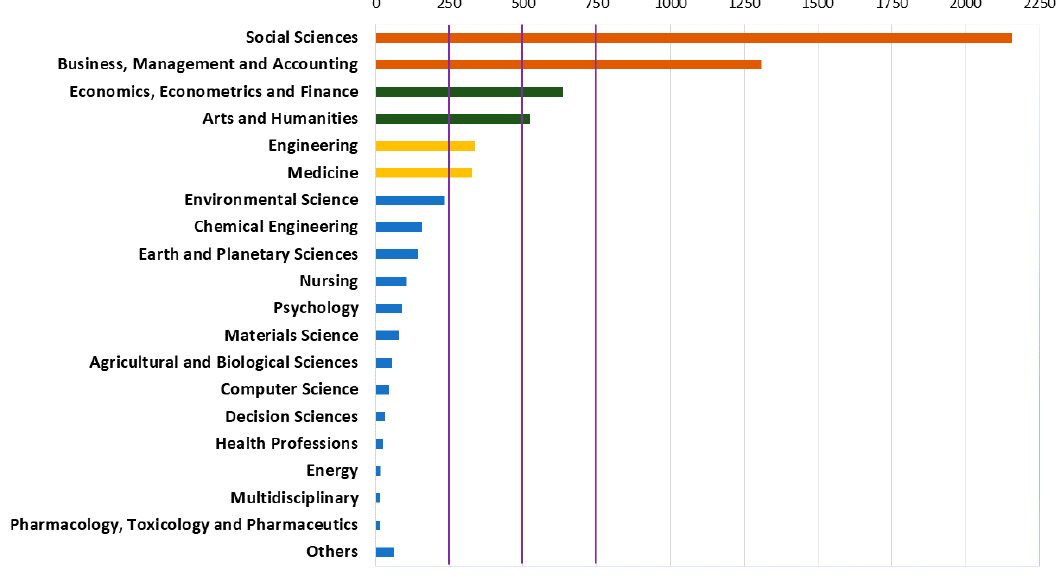
Figure 6. Distribution of publications by field, as classified by Scopus.